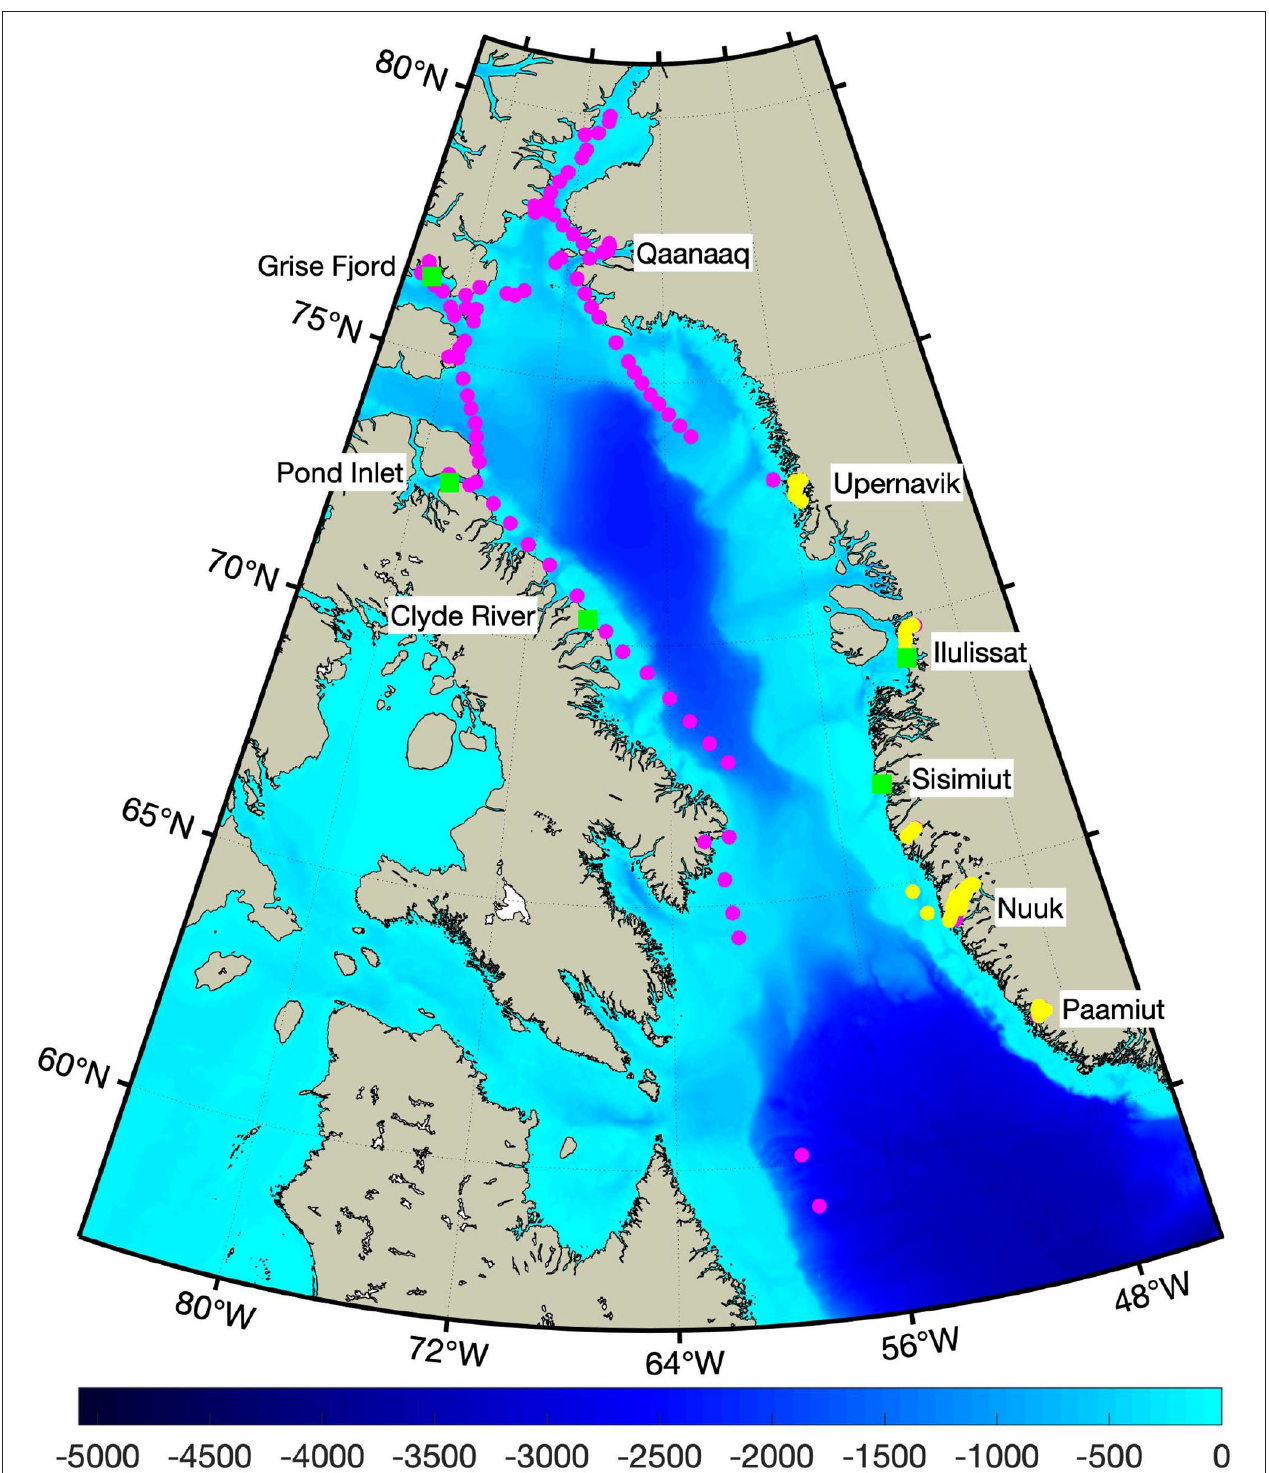
FIGURE 1 | A map of Baffin Bay and the Labrador Sea, bordered by Greenland on the east and Canada to the west. Circles are used to indicate CTD profile locations colored to represent the instrument that was used. Yellow circles correspond to the RBR Concerto and pink circles correspond to the Sontek CastAway. Colored contours indicate ocean bathymetry (meters below sea level) derived from ETOPO1 (NOAA National Geophysical Data Center, 2008).